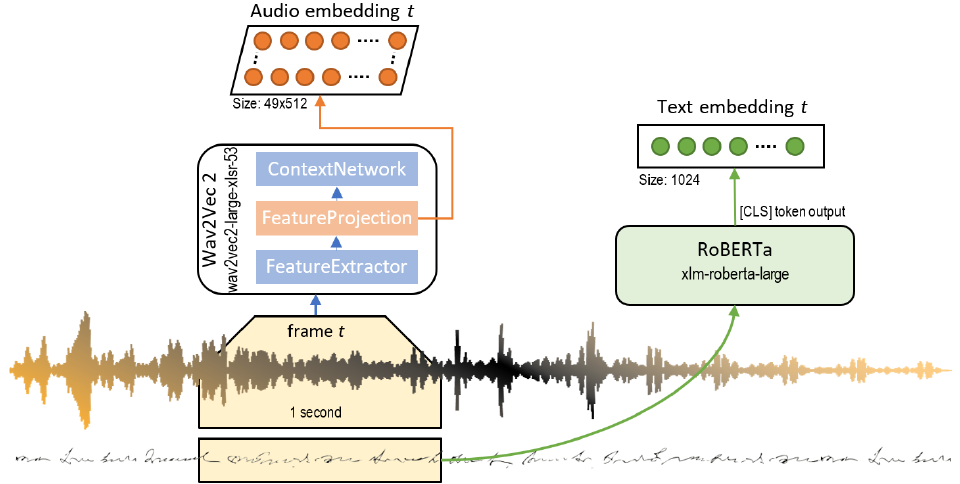
Figure 8. Extraction of text and audio